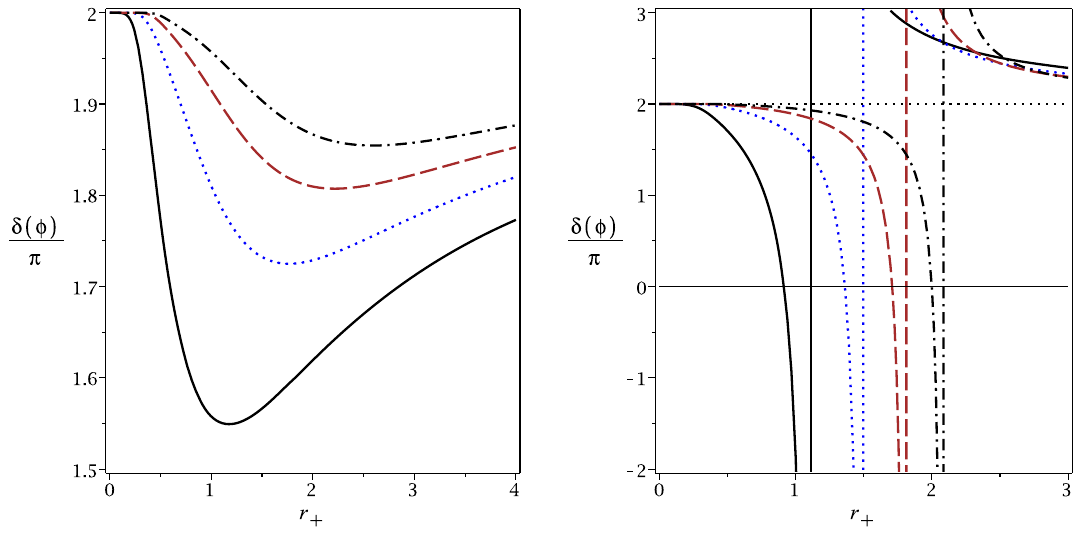
Fig. 5 PMI solutions: δ (φ) versus r + for q = 0 . 1, c = c 1 = c 2 = c 3 = c 4 = m = l = 1, s = 0 . 9, d = 5 (continuous line), d = 6 (dotted line), d = 7 (dashed line) and d = 8 (dashed-dotted line). Left diagram: (cid:3) = − 1; right diagram: (cid:3) =